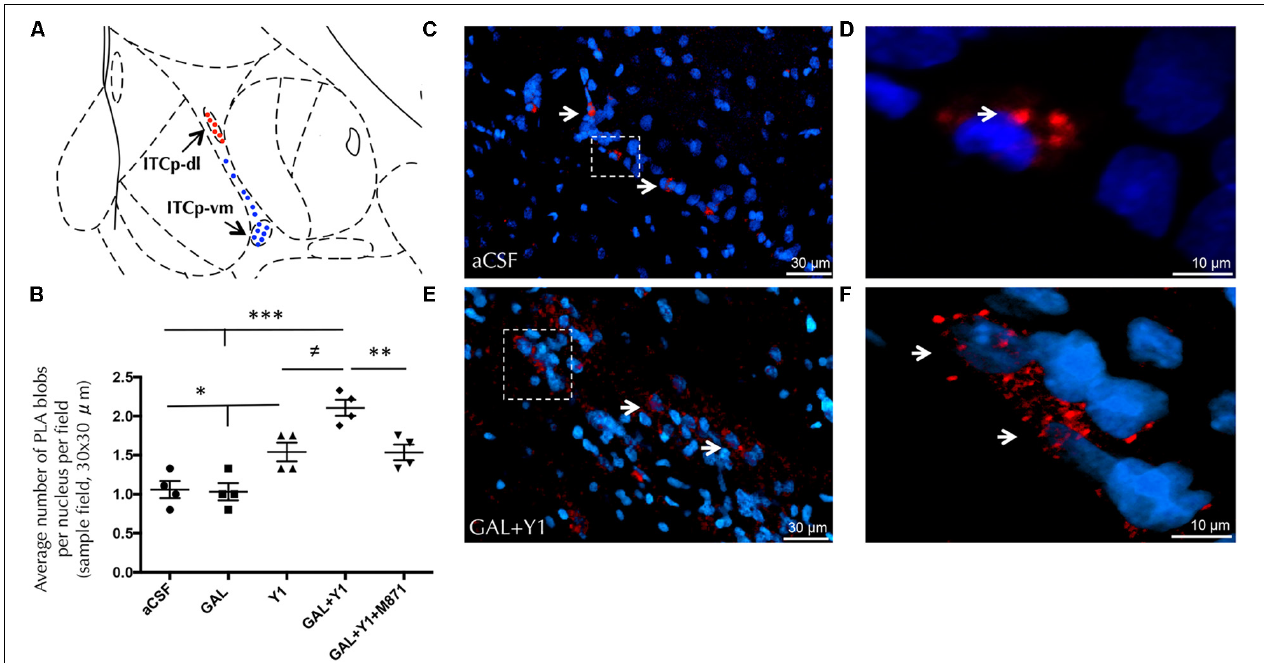
FIGURE 7 | Detection of GALR2/NPYY1R heteroreceptor complexes with in situ PLA in the dorsolateral cluster of medial paracapsular intercalated islands of the amygdala (ITCp-dl). (A) Diagram shows the presence of positive PLA signals (red circles) in the ITCp-dl and lack of specific signals (blue circles) in the ventromedial cluster (ITCp-vm). [Bregma: –2.3 mm; according to the Paxinos and Watson (1986) stereotaxical atlas]. (B) Quantification of PLA signals in ITCp-dl was performed by measuring blobs per nucleus per sampled field by an experimenter blind to treatment conditions. Sprague Dawley rats showed a significant increase in GALR2/NPYY1R heteroreceptor complexes (PLA blobs) in the ITCp-dl cluster after GAL and NPYY1 agonist coinjection. This effect was blocked by the presence of the GALR2 antagonist M871. ∗ P < 0.05; ∗∗ P < 0.01; ∗∗∗ P < 0.001; (cid:54)= P < 0.05 according to one-way ANOVA followed by Newman–Keuls Multiple Comparison Test. Inter-group comparisons are indicated by the lines above bars. Data are expressed as mean ± SEM and each point in the graph represents results from individual rats from multiple photographs analyzed ( N = 4 rats per group). (C–F) Representative microphotographs of the significant increase in the density of GALR2/NPYY1R positive red PLA blobs in the ITCp-dl subregion after GAL and NPYY1 agonist coinjection (E) compared with control group (C) . Magnified views from dashed boxes in C,E are shown in (D) and (F), respectively. GALR2/NPYY1R heteroreceptor complexes are shown as red PLA blobs (clusters) found in high densities per cell in a large number of nerve cells using confocal laser microscopy, White arrows point to PLA clusters. The nuclei are shown in blue by DAPI. Abbreviations: aCSF, cerebrospinal fluid; GAL, Galanin 3 nmol; Y1, NPY Y1 receptor agonist [Leu 31 -Pro 34 ]NPY 3 nmol; GAL+Y1, Coadministration of GAL and [Leu 31 -Pro 34 ]NPY; GAL+Y1+M871, Coadministration of GAL, [Leu 31 -Pro 34 ]NPY and GALR2 antagonist M871 3